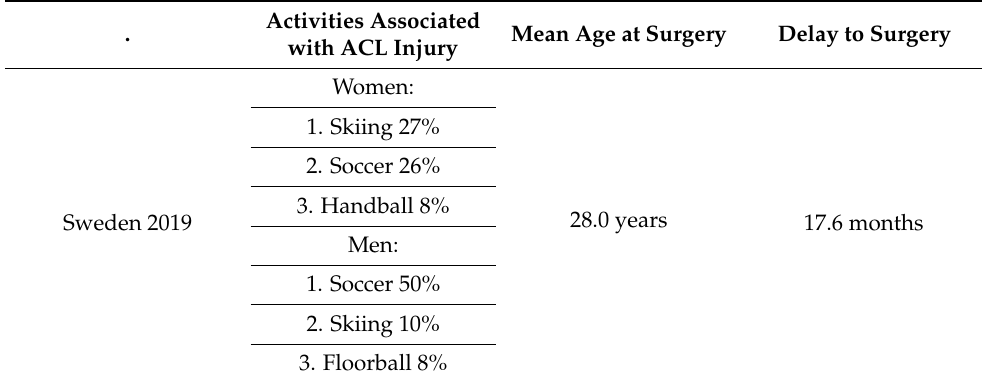
Table 1. Country-specific differences regarding activities associated with ACL injury, patients’ mean age at surgery, and delay to